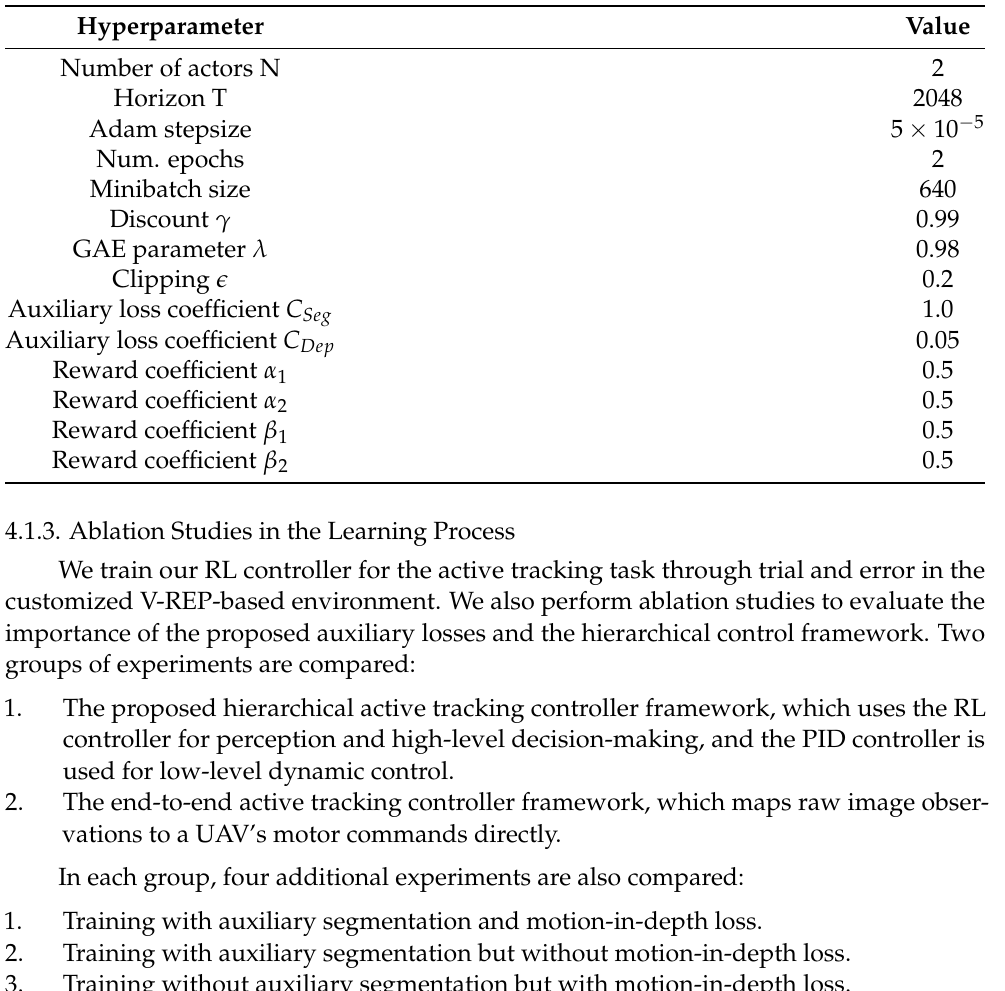
Table 1. Hyperparameters in our